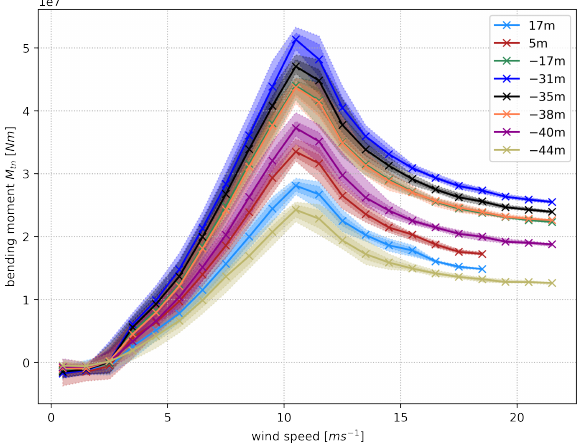
Figure 5. Bending curves at the various instrumented water depths to extract the QS mode shape.